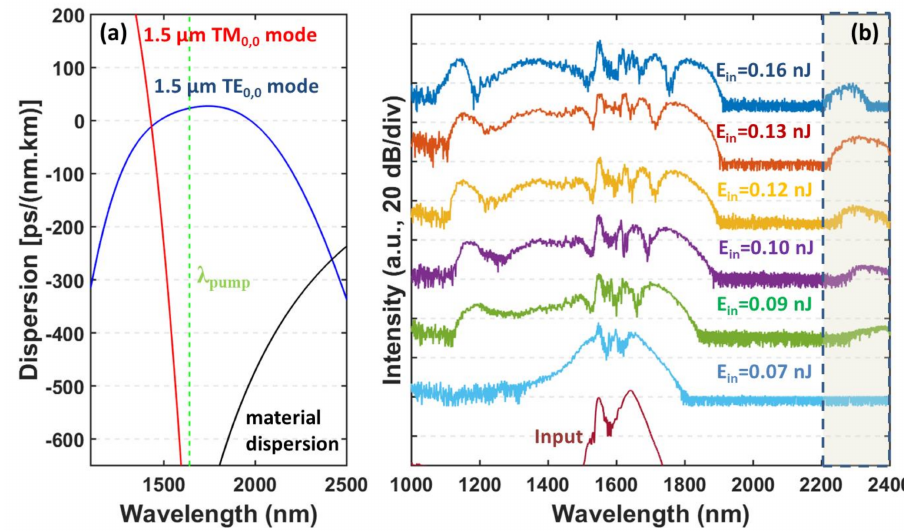
Figure 4. ( a ) Dispersion profiles of the fundamental TE 0,0 and TM 0,0 modes of the 1.5 µ m wide waveguide. The material dispersion is plotted with solid black line. ( b ) Optical supercontinua measured at the output of the TiO 2 waveguide for various coupled energy conditions. For the better reading of the figure, the various spectra were vertically offset. The part of the spectrum ranging from 2200 nm to 2400 nm has been shaded because residual contribution of spurious double-order mode may contribute to the